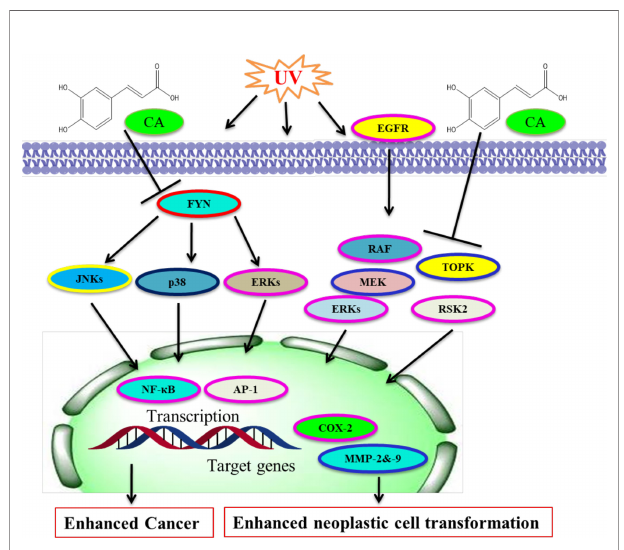
FIGURE 4 | Molecular targets of caffeic acid. CA binds with Fyn for blocking its kinase activity and UV-mediated skin cancer. CA binds with MEK and TOPK to prevent their kinase actions and neoplastic cell transformation. [Adapted from Bode et al. (245)]. This fi gure was drown by